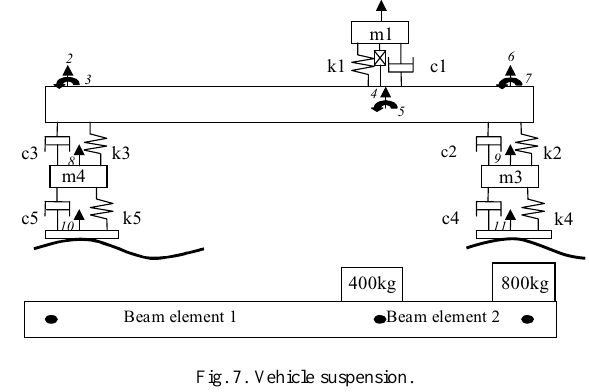
Fig. 7. Vehicle suspension.